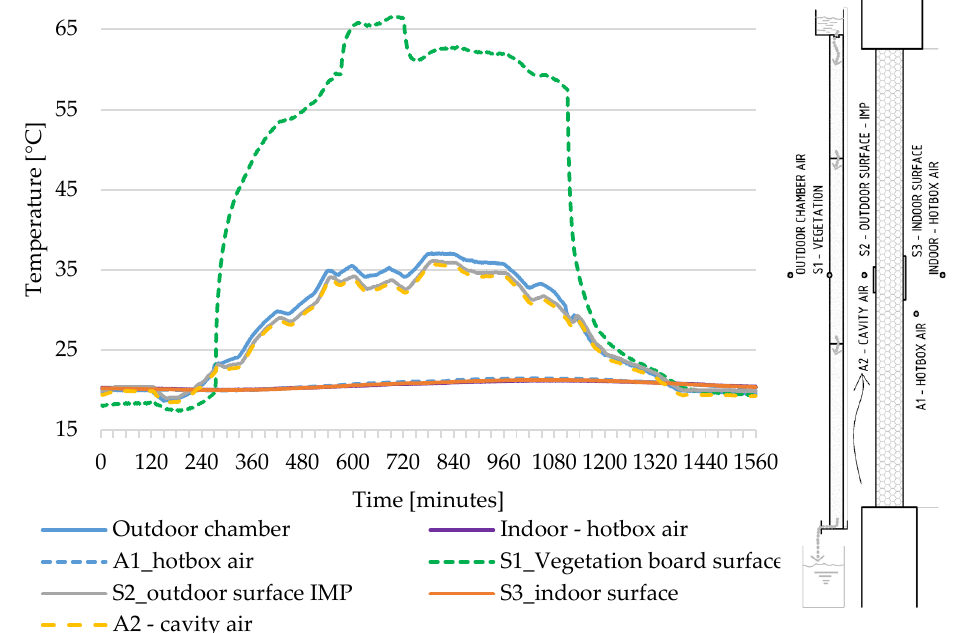
Figure 6. The temperature course for the setup with the vegetation board. Without watering. Increase in S3 indoor surface temperature from 20.2 to 22.3 ◦ C (temperature difference ∆ θ si = 2.1 K).